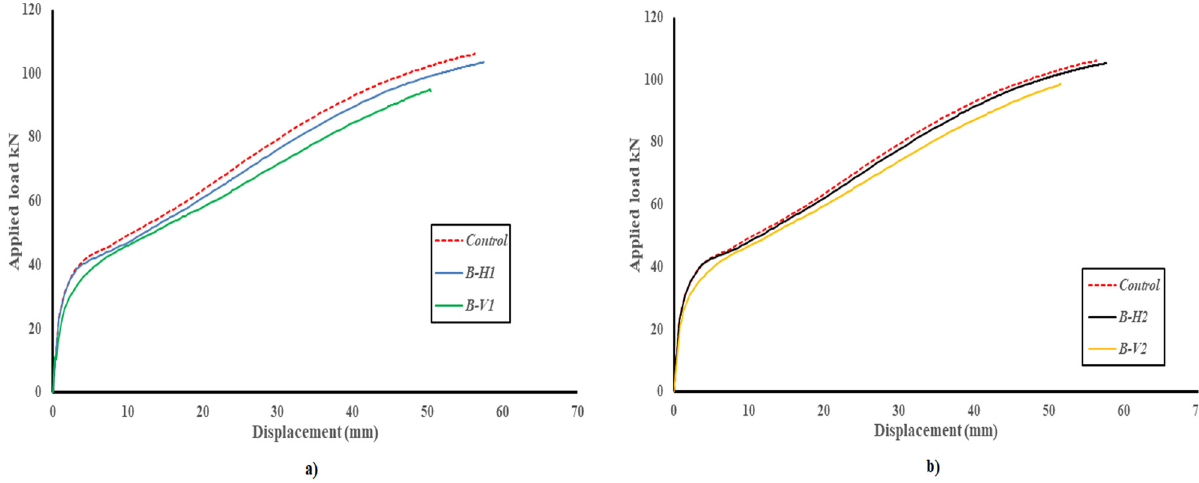
Figure 5: Load – midspan de fl ection response for analyzed beams ( e ff ect of opening orientation ) . ( a ) Beams with one opening and ( b ) beams with two openings.